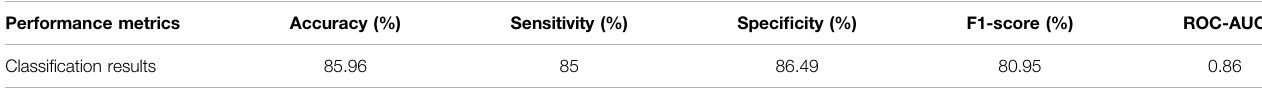
TABLE 3 | Performance of predicting individual treatment outcomes with all imaging and genetic features. Performance metrics